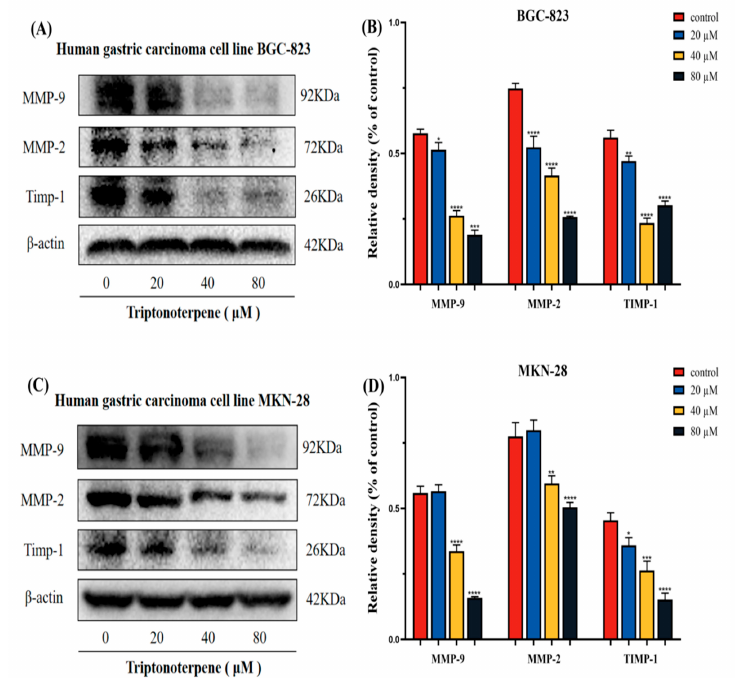
Figure 8. The expression of the MMP ‐ related proteins in the GC cells was detected using Western blots. ( A , B ) Expression levels of MMP ‐ 9, MMP ‐ 2, and Timp ‐ 1 in the BGC ‐ 823 cells. ( C , D ) Expression levels of MMP ‐ 9, MMP ‐ 2, and Timp ‐ 1 in the MKN ‐ 28 cells. * p < 0.05, ** p < 0.01, *** p < 0.001, and **** p < 0.0001.